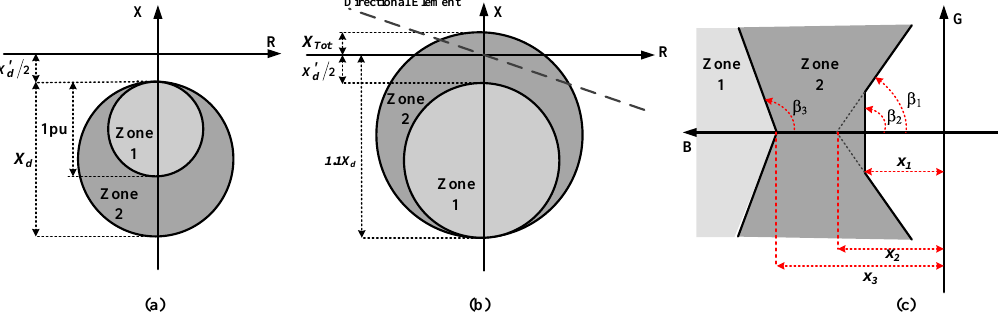
Figure 1. The characteristics of traditional LOE relays including the R–X scheme ( a ), the 𝑅 − 𝑋 scheme with DE ( b ) and 𝐺 − 𝐵 scheme ( c ).